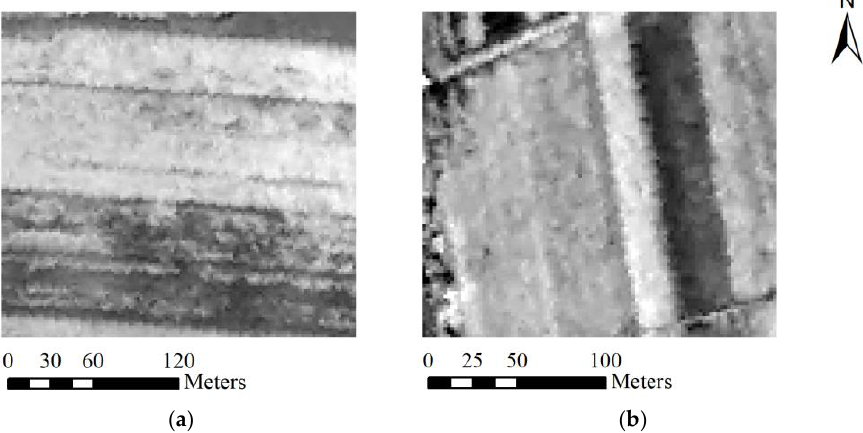
Figure 8. The cropland with rowing from east to west ( a ) and south to north ( b ).